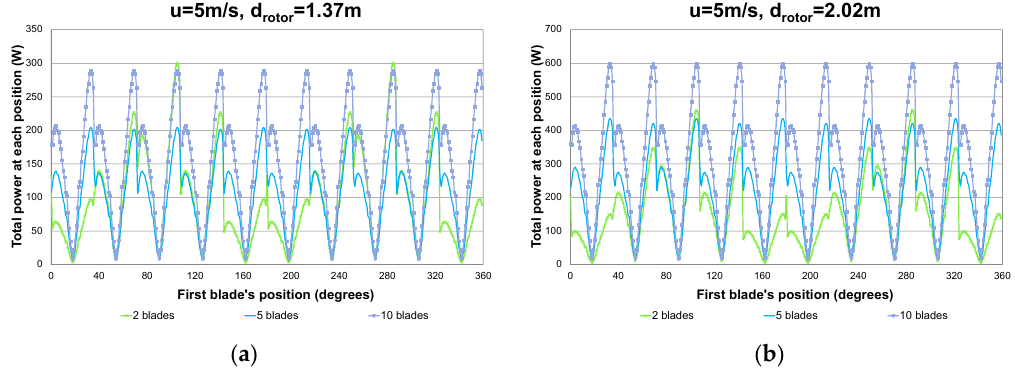
Figure 6. Total power at each blade’s position for wind velocity 5 m/s, various numbers of blades and rotor’s diameter ( a ) 1.37 m; ( b ) 2.02 m.